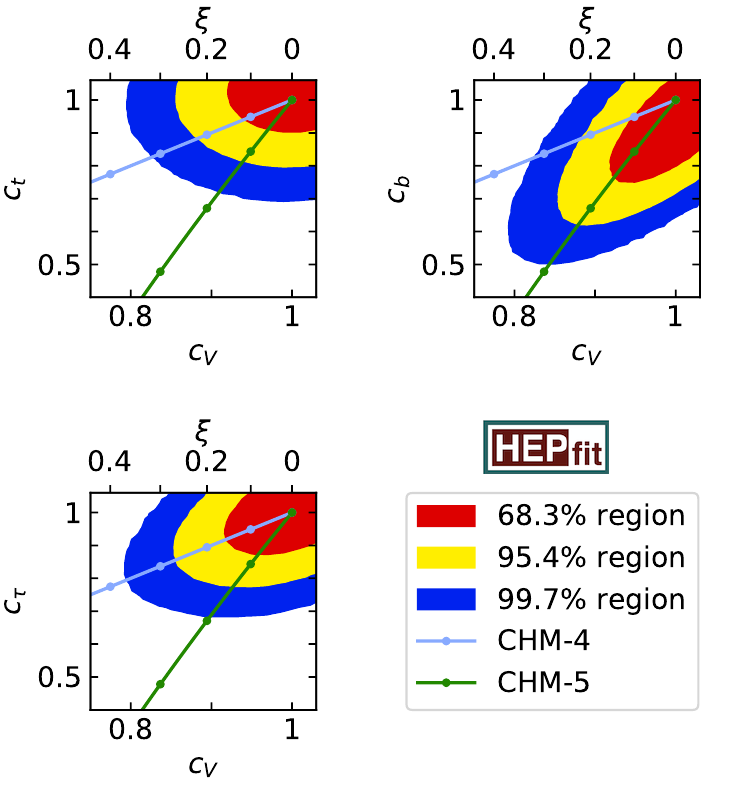
Figure 7 . Magni(cid:12)cation of the c vs. c V planes from (cid:12)gure 5, together with the lines corresponding to the two composite Higgs scenarios discussed in the text. The dots on the lines correspond to values of (cid:24) =0, 0.1, 0.2, 0.3, 0.4 in the direction from c V = 1